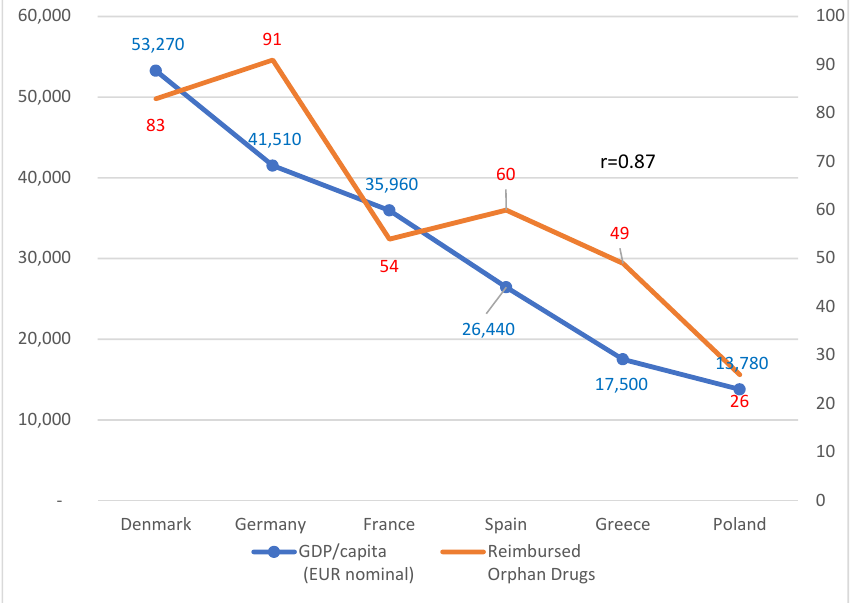
Figure 4. Number of reimbursed Orphan Drugs vs. GDP per capita in six EU Countries (2019). All Orphan Drugs with agreed List Price in the Country and reimbursed by public health insurance system are recognized as reimbursed. including drugs dispensed through open pharmacies. hospital pharmacies. or through special Drug Programs. GDP per capita values sourced from Eurostat.